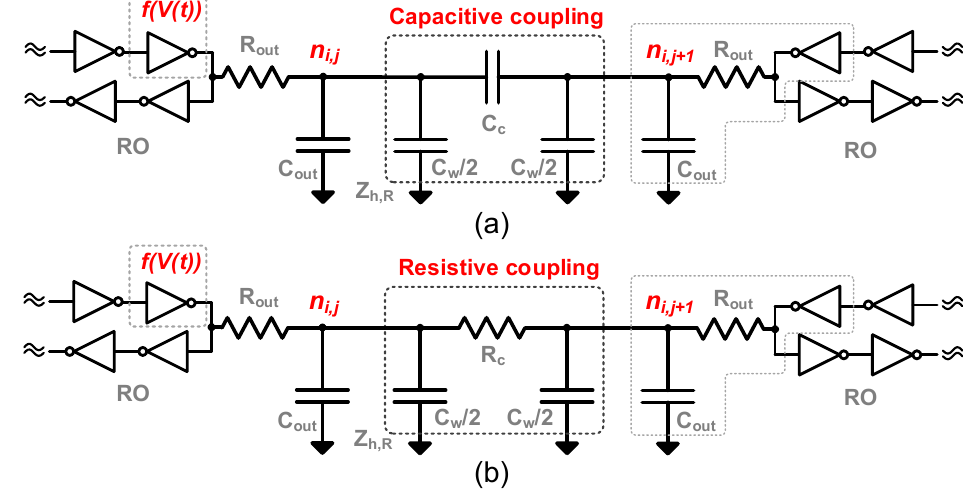
Figure 5. ( a ) Capacitive and ( b ) Resistive coupling elements between two generic ring oscillators (ROs) (only Z h , R